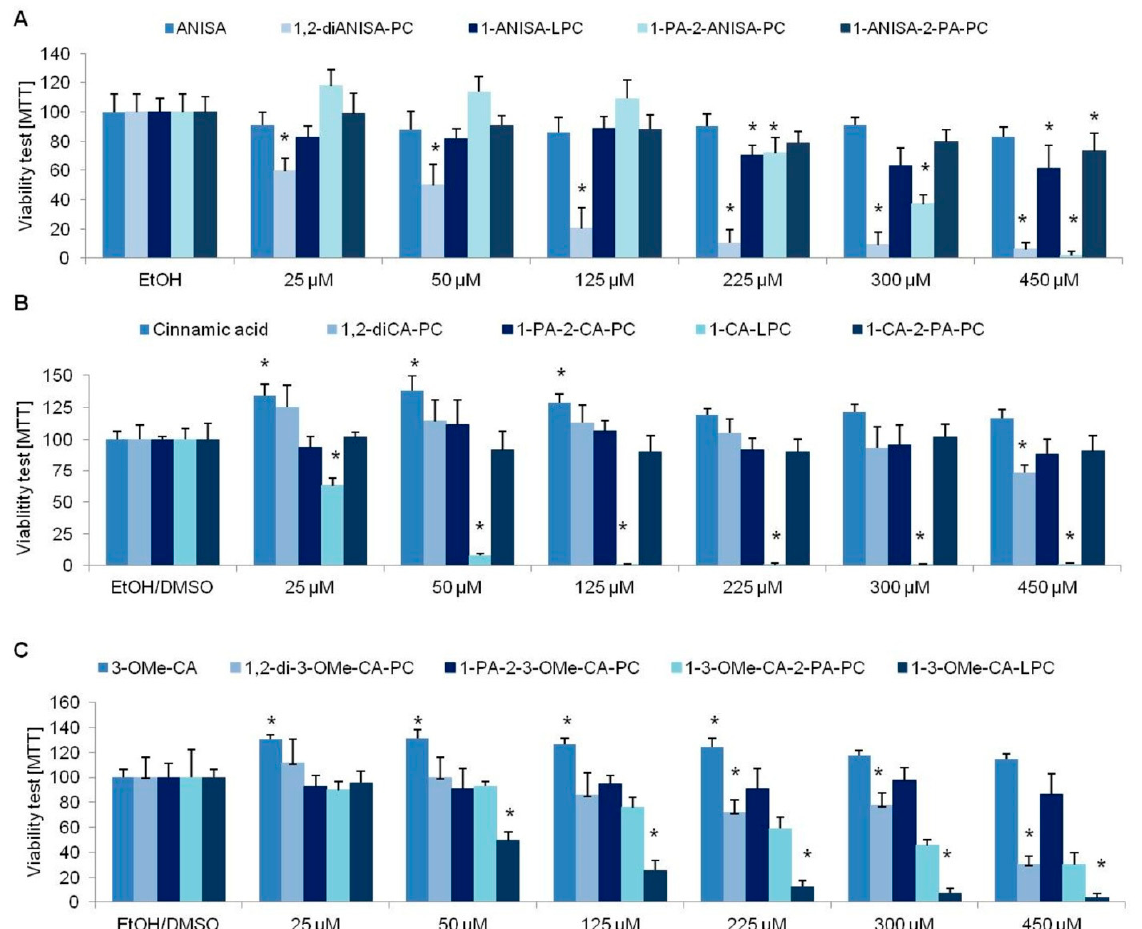
Figure 2. The effect of various concentrations of phospholipid derivatives of anisic acid ( A ), cinnamic acid ( B ), and 3-methoxycinnamic acid ( C ) on the viability of 3T3-L1 cells. Student’s t -test, * p < 0.05.